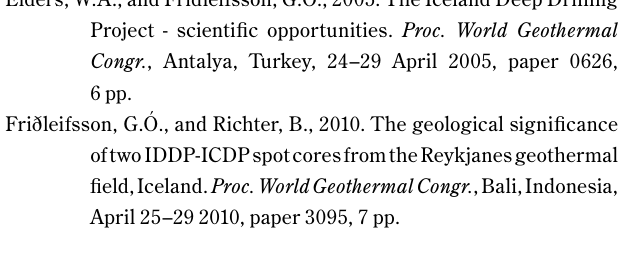
Figs. 2, 3, 7, and 8 by G.Ó. Friðleifsson, H.S. Orka, and